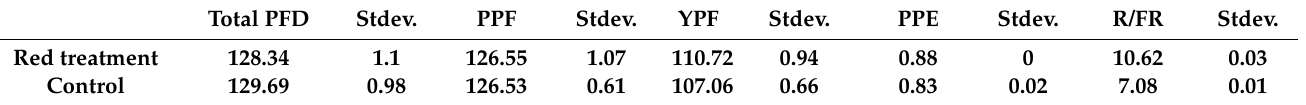
Total photon flux density (PFD) ( µ mol · s − 1 ), photosynthetic photon flux